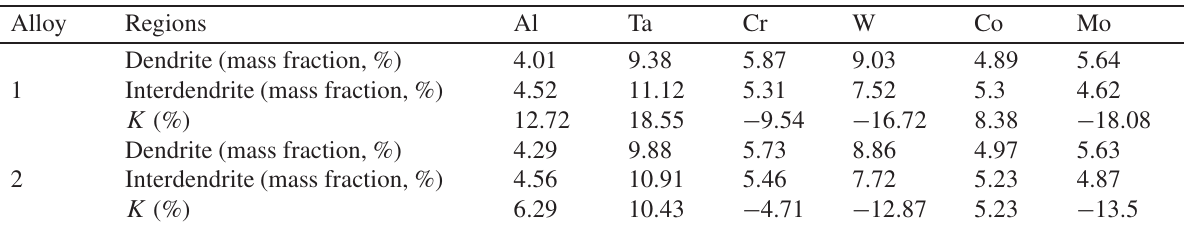
Table 2. Distribution and segregation coefficients of the elements in the interdendrite/dendrite regions of the alloys after fully heat treated.